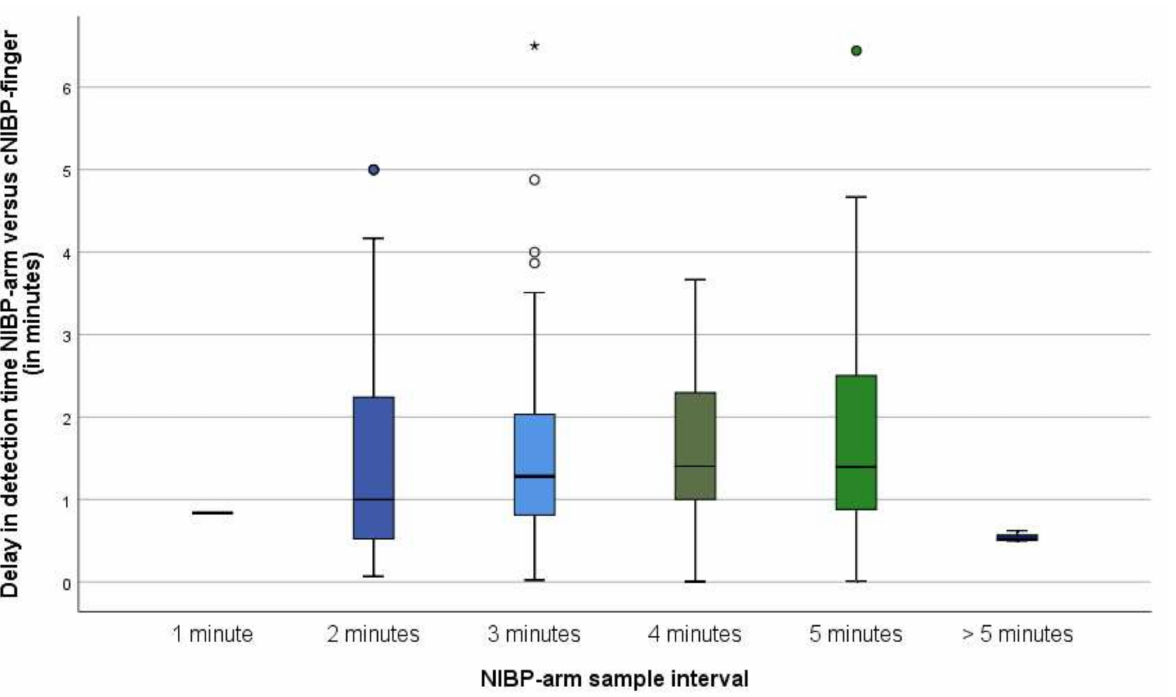
Figure 1. Boxplots demonstrating median delay time per NIBP-arm sample interval. The NIBP-arm sample interval was the sample interval the patient experienced for the majority of surgical time. To illustrate, if a patient had a duration of surgery of 120 min and 10 min were sampled at an interval of 2 min and the remaining 110 min were sampled at an interval of 3 min, we listed this as a sample interval of 3 min. The round dots represent outliers within the presented scale. The asterisk represents an outlier outside of the presented scale; it represents a 9.7 min delay in detection